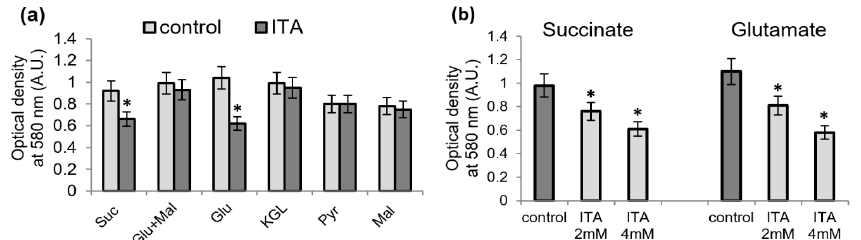
Figure 2. Influence of itaconic acid on the oxidation of mitochondrial substrates, as measured by MTT reduction. Influence of itaconic acid (ITA, 2 mM) on MTT reduction after a 5-min incubation with mitochondria upon the oxidation of succinate and NAD-dependent substrates ( a ); inhibition of MTT reduction by different concentrations of ITA upon the oxidation of succinate (2 mM) or glutamate (2 mM) ( b ). Asterisks (*) indicate values that differ significantly from the control values ( p < 0.05).